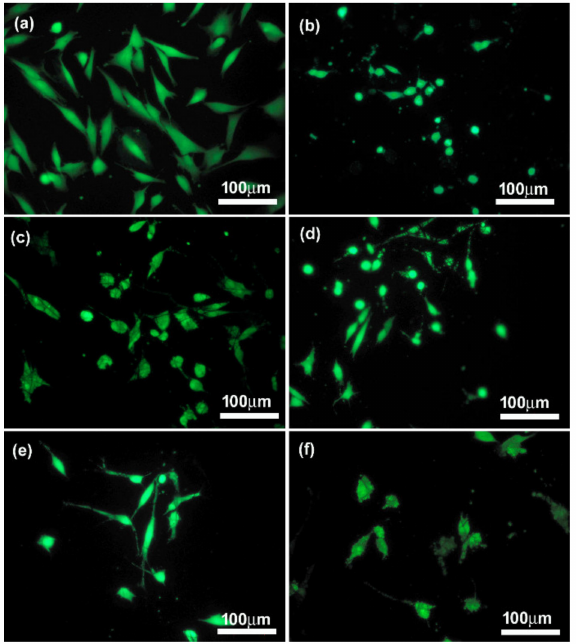
Figure 11. Merged microphotographs of human chondrocyte cell line (CHON-001) stained with calcein AM/propidium iodide grown on control (PS) ( a ) and CNF before ( b ) and after surface modification: ( c ) CNF_ox, ( d ) CNF_NaH, ( e ) CNF_GO and ( f )